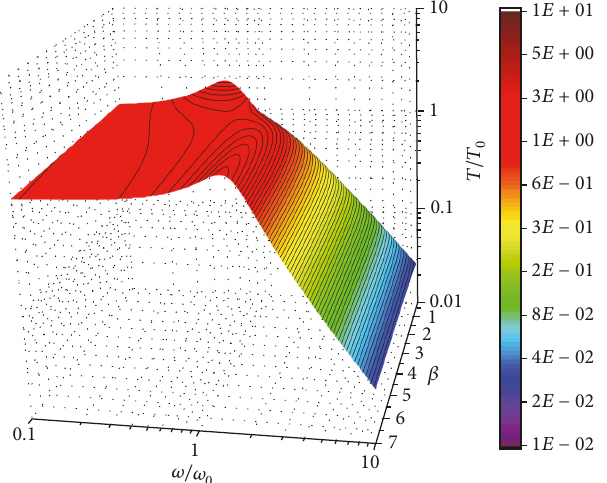
Figure 50: Transmissibility surface ( 𝛼 = 3, 𝛽 =